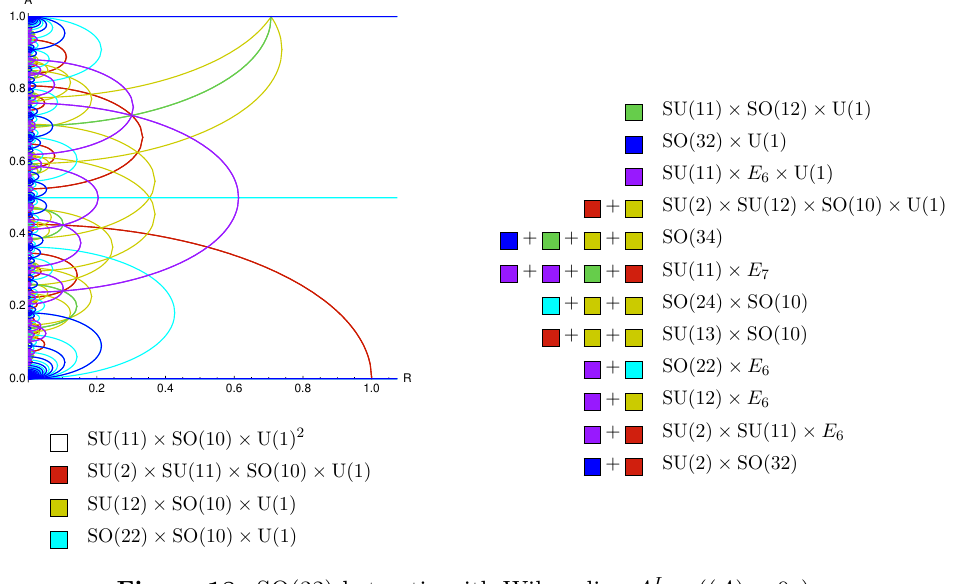
Figure 18. SO(32) heterotic with Wilson line A I = (( A ) 11 ; 0 5 ).